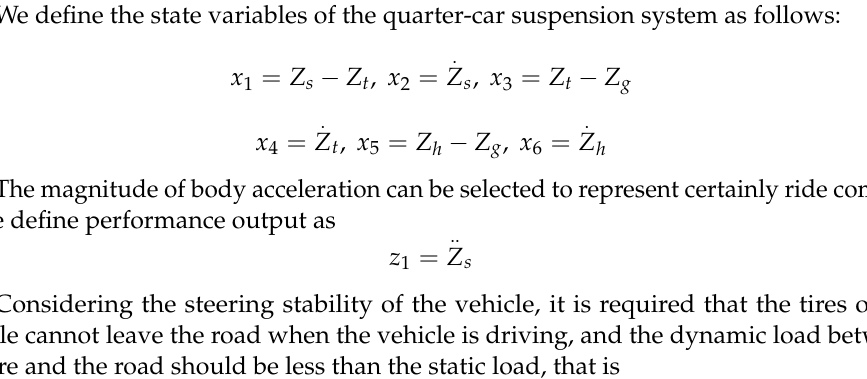
Figure 2. Schematic diagram of linear fractional transformation (LFT) structure.